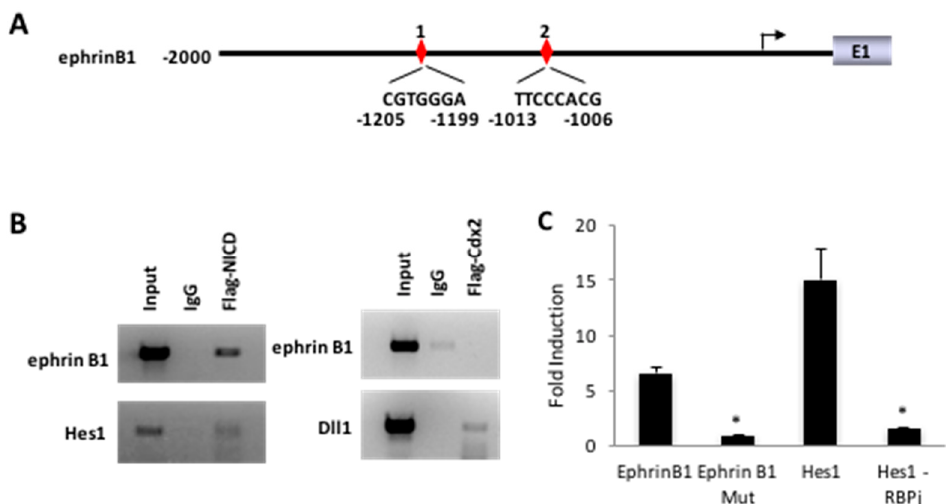
Figure 3. EphrinB1 is a Notch target gene. ( A ) Schematic representation of putative RBPJ binding sites in the EphrinB1 promoter. ( B ) Chromatin immunoprecipitation (ChIP)-PCR analysis of the Ephrin B1 locus from SW480 cells showing NICD occupancy (left panel) of the regions encompassing the RBPJ binding sites. Cdx2 did not occupy the EphrinB1 promoter (right panel). Hes1 and Dll1 were used as positive controls for NICD and Cdx2 , respectively. ( C ) Notch signaling induces expression from the EphrinB1 promoter in cell-based assays in wild type, but not RBPJ binding motif mutant (Mut), reporters. Hes1 and Hes1 RBPJ binding motif mutant (Hes1-RPBj) expression vectors were used as positive and negative controls, respectively. Error bars represent the standard deviation from three independent samples. * p < 0.05 relative to control by Student’s t -test.